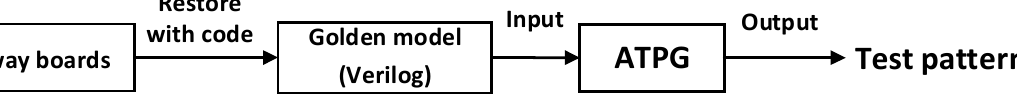
Figure 5. Algorithm test logic diagram.